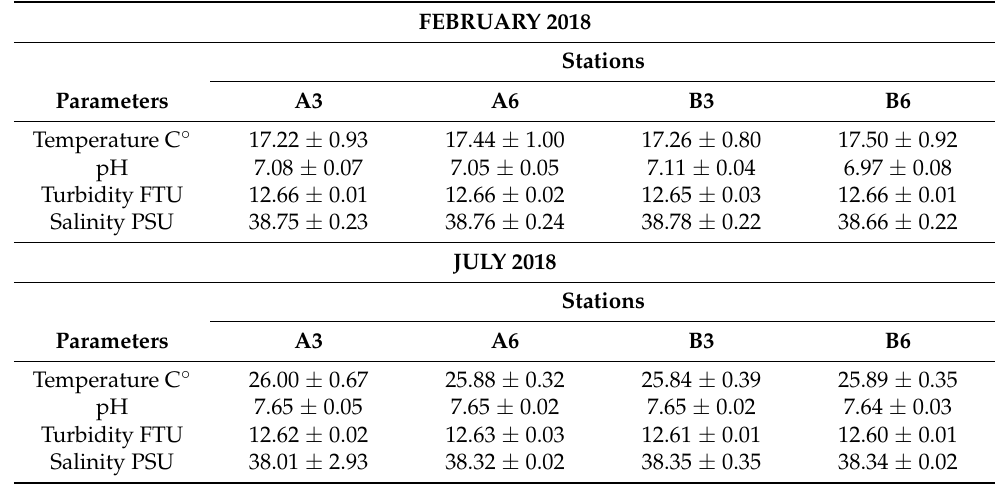
Table 3. Physical and chemical parameters measured in February and July 2018 (from [28] with permission from IEEE, 2022, Copyright Clearance Center’s RightsLink ® ).